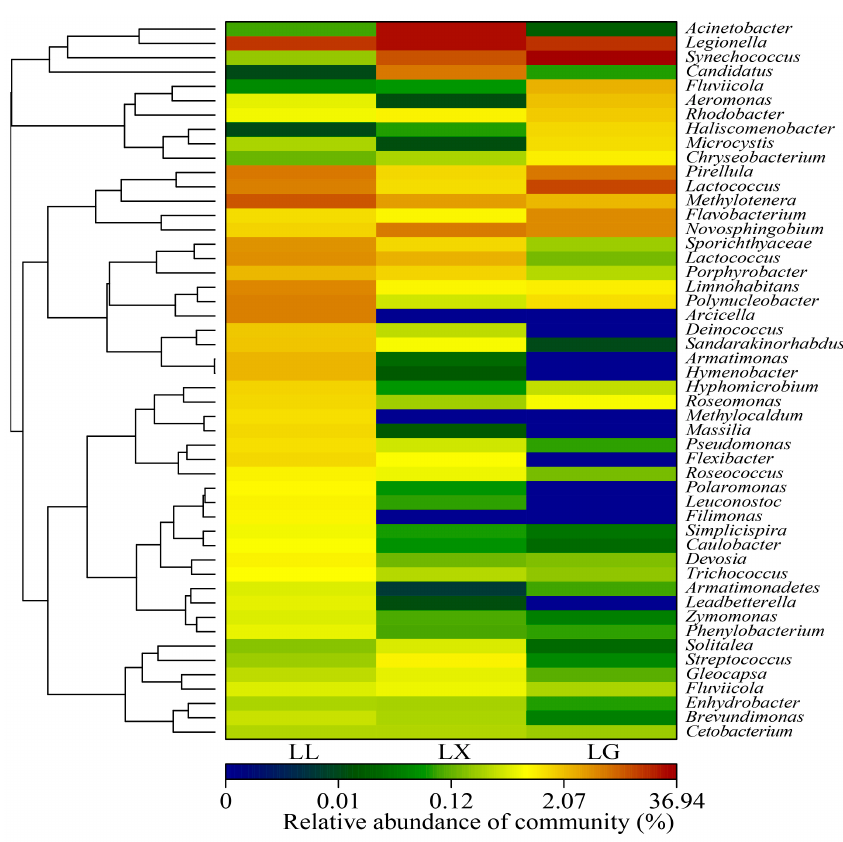
Figure 5. Heat map profile showing 50 representative predominant 16S rRNA gene-based sequence classified at the genus level using the Ribosomal Database Project (RDP) classifier database. LX, LG and LL represent Xingqing lake, Geming lake and Lianhu lake, respectively.